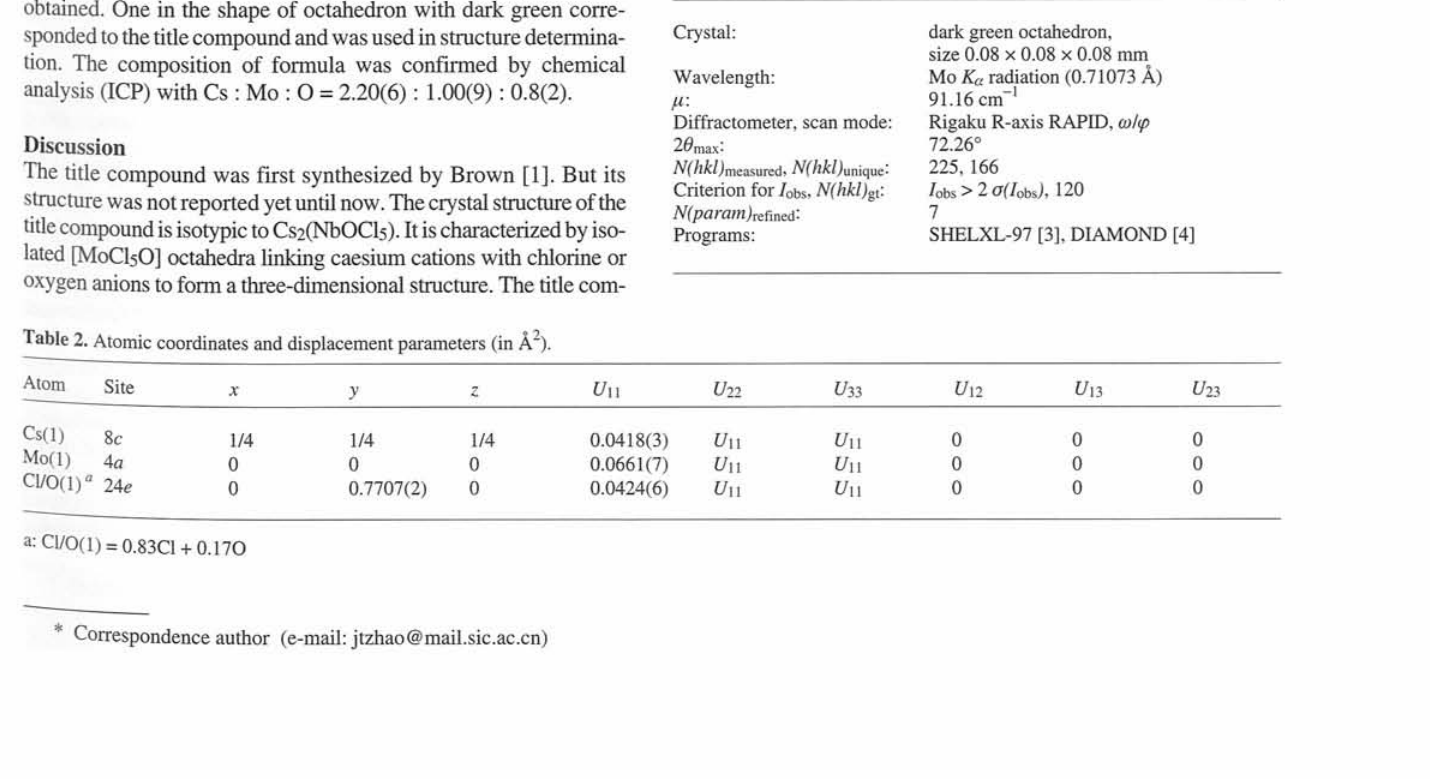
Table 1. Data collection and handling.